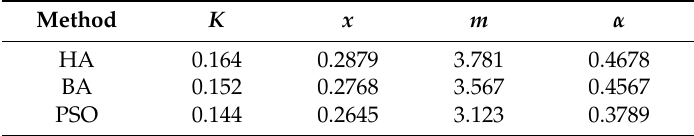
Table 8. Extracted coefficients for the four-parameter Muskingum